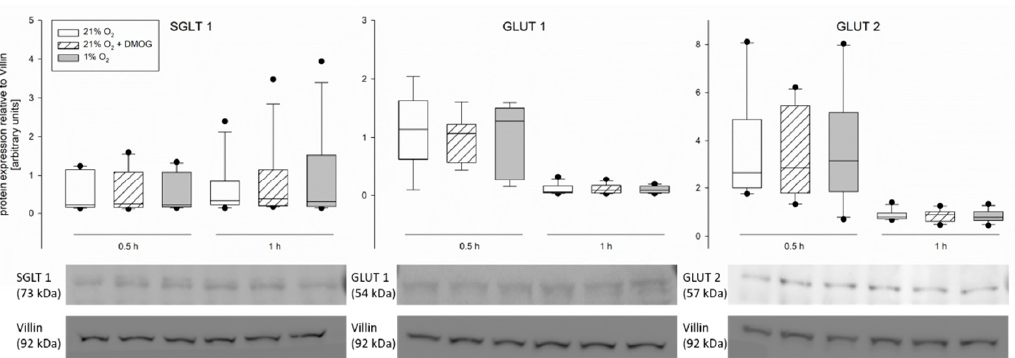
Figure 5 . Protein expression of SGLT1, GLUT1, and GLUT2 in CaCo-2 cells detected by Western blot. Cells were incubated at 21% O 2 (white bars) or at 21% O 2 with 3 mM DMOG (hatched bars) or subjected to hypoxia (grey bars). There is no significant difference between the treatments. Representative blots are shown below. Boxes show the median, 10th, 25th, 75th, and 90th percentile plus error bars. Outliers are represented by dots. Paired t-test, N = 5 ( n = 10) for 0.5 h and N = 6 ( n = 12) for 1 h.